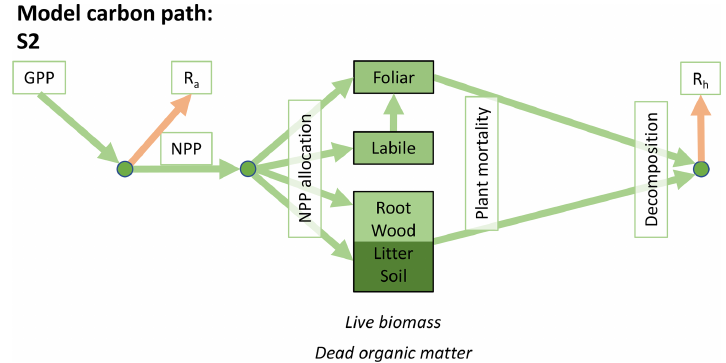
Figure B5. Carbon cycle structure for model S2.